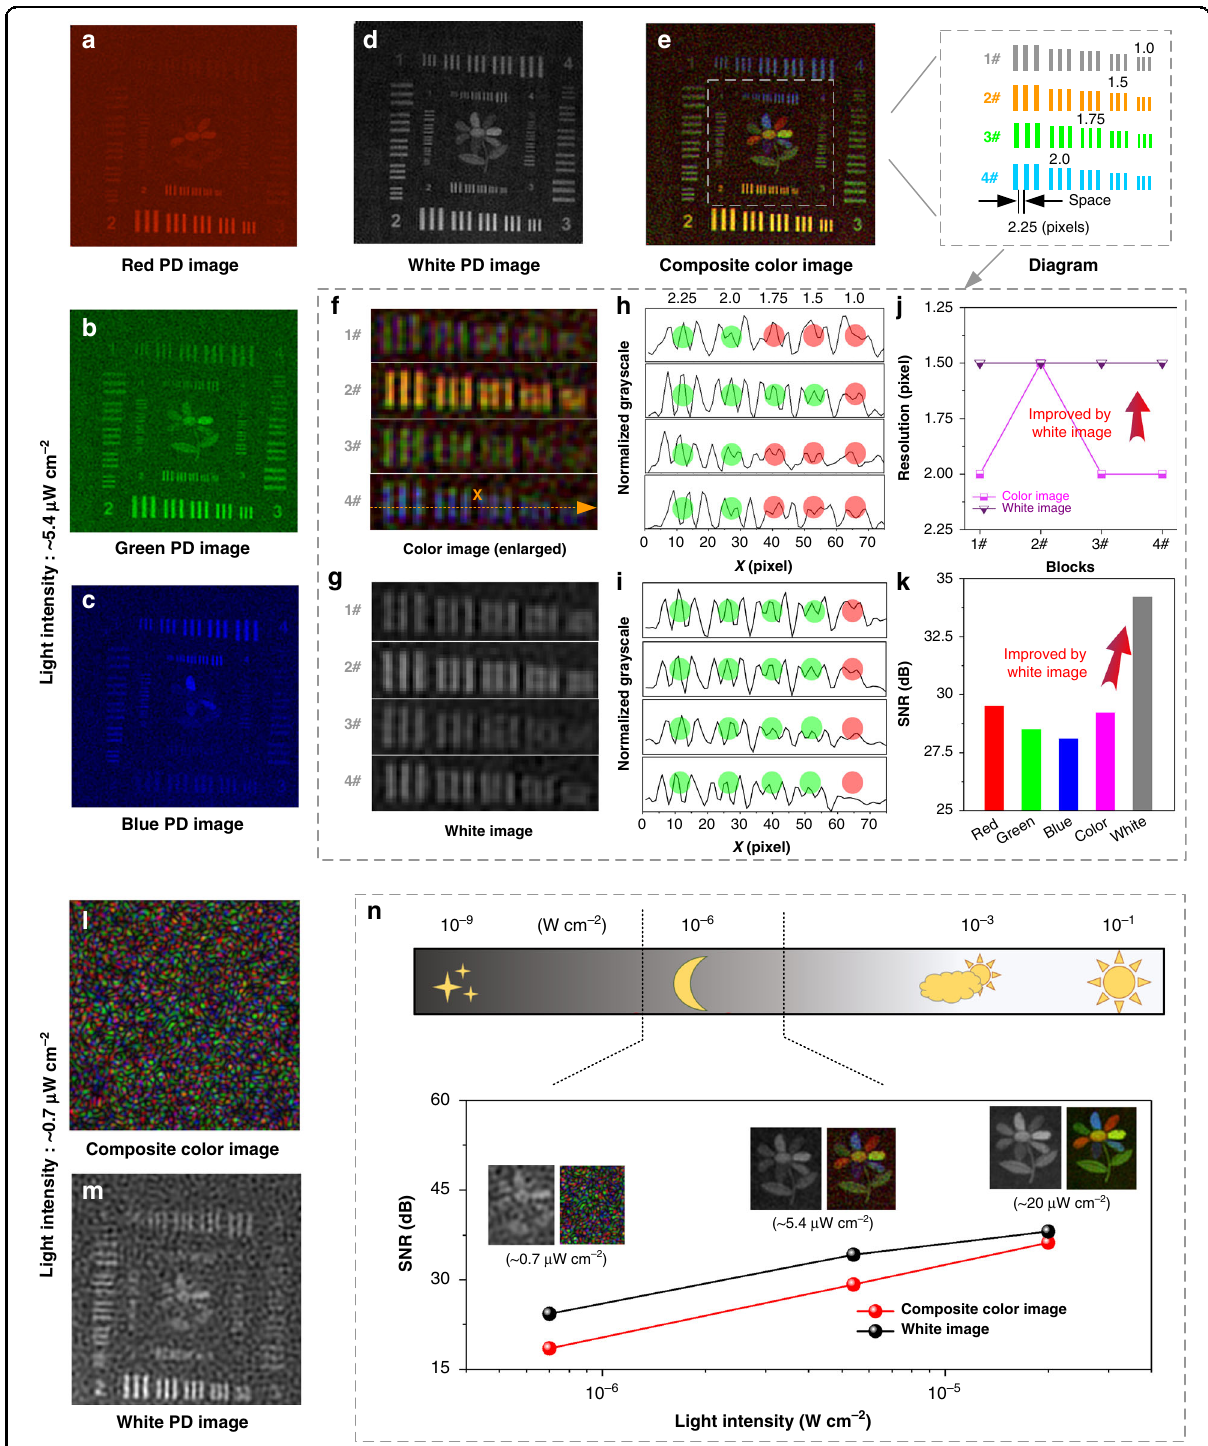
Fig. 5 Demonstration of color imaging with weaker light illuminations. a – d Images by narrowband RGB PDs and broadband W PD under a light intensity of ~5.4 μ W cm − 2 . e Composite color image. Inset is a diagram of space between blocks for calculating resolution. f , g Enlarged images of blocks are depicted in the inset of e , respectively. h , i Normalized grayscale of line x in f , g , respectively. j Calculated resolution. k Calculated signal-to- noise ratio (SNR) of images. l , m Composite color and white images were obtained by our camera under a light intensity of ~0.7 μ W cm − 2 . n A summary exhibition of imaging results of our perovskite-based color camera under different light